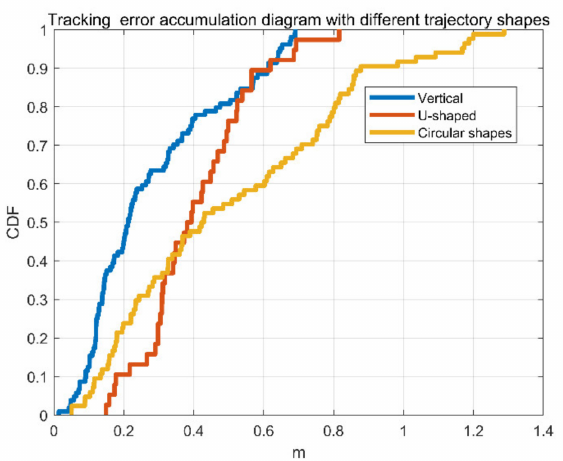
Figure 17. Error accumulation diagram of the trajectory errors with different trajectory shapes.